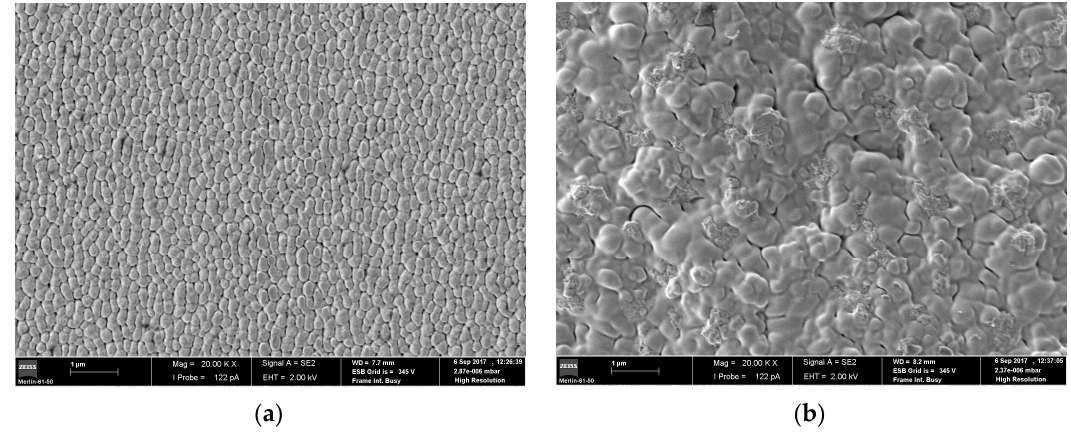
Figure 4. Surface images (SEM) of Ni/Al multilayer thin films deposited onto ( a ) Si flat substrates; ( b ) W wire curved